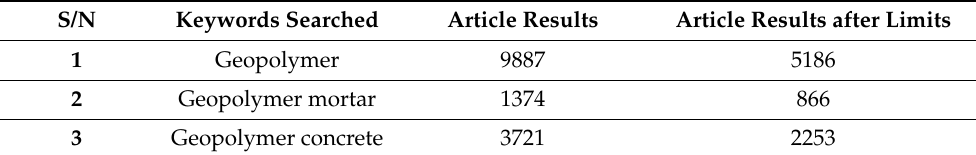
Table 2. Searched keywords and returned documents from Scopus as of 25 April 2022.